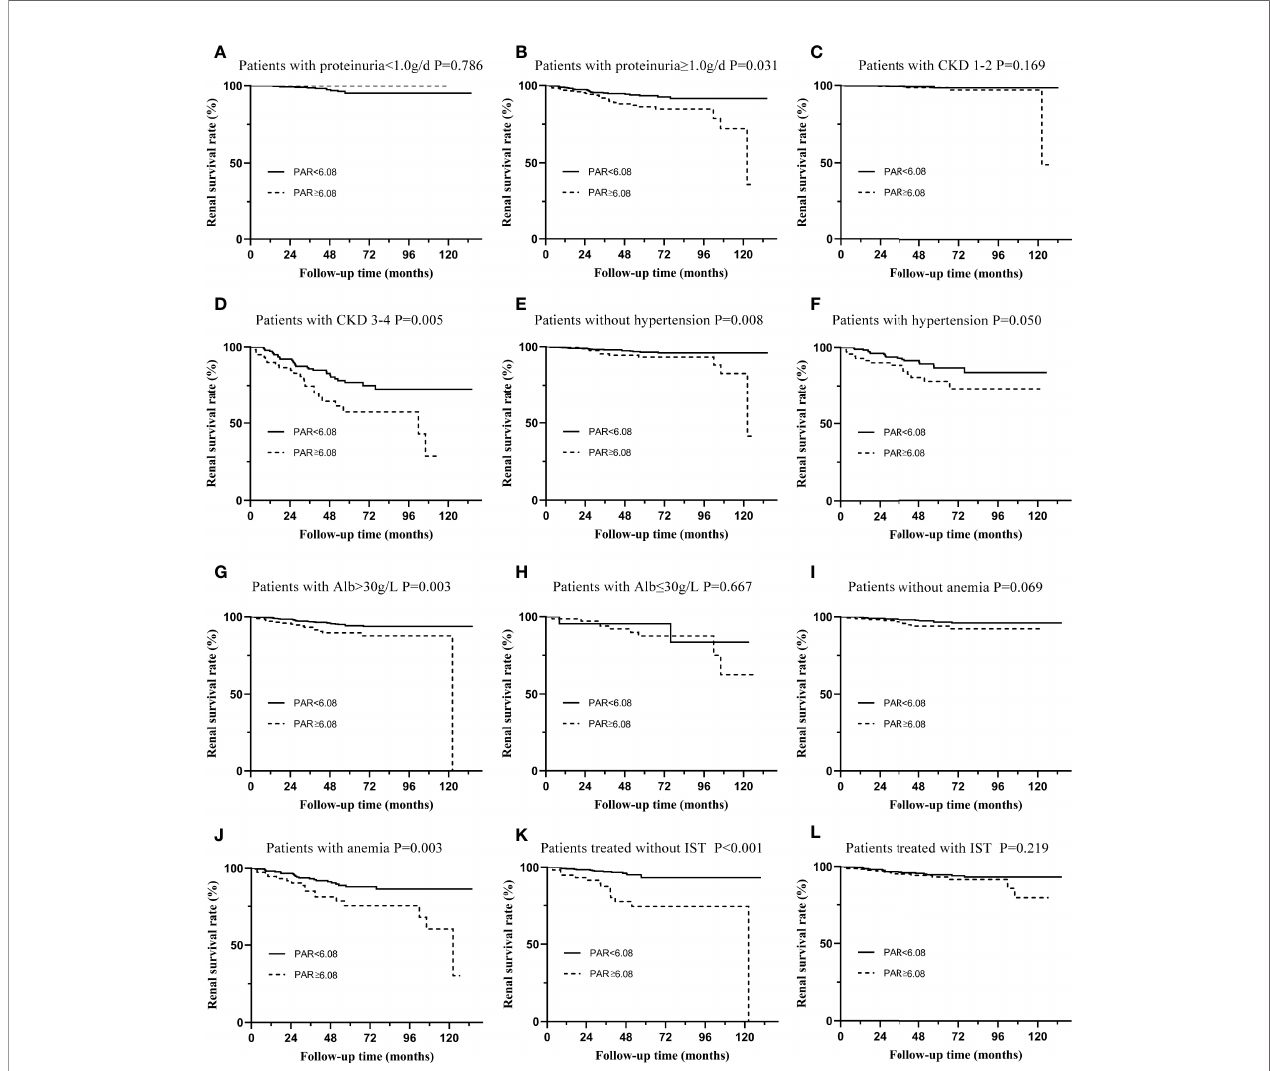
FIGURE 5 | Subgroup analysis of IgAN patients with different types of clinical manifestations. (A) The renal survival curve of patients with proteinuria ≤ 1.0g/d in two groups separated by PAR. (B) The renal survival curve of patients with proteinuria ≥ 1.0g/d in two groups separated by PAR. (C) The renal survival curve of patients with CKD 1-2 in two groups separated by PAR. (D) The renal survival curve of patients with CKD 3-4 in two groups separated by PAR. (E) The renal survival curve of patients without hypertension in two groups separated by PAR. (F) The renal survival curve of patients with hypertension in two groups separated by PAR. (G) The renal survival curve of patients with Alb>30g/L in two groups separated by PAR. (H) The renal survival curve of patients with Alb ≤ 30g/L in two groups separated by PAR. (I) The renal survival curve of patients without anemia in two groups separated by PAR. (J) The renal survival curve of patients with anemia in two groups separated by PAR. (K) The renal survival curve of patients treated without IST in two groups separated by PAR. (L) The renal survival curve of patients treated with IST in two groups separated by